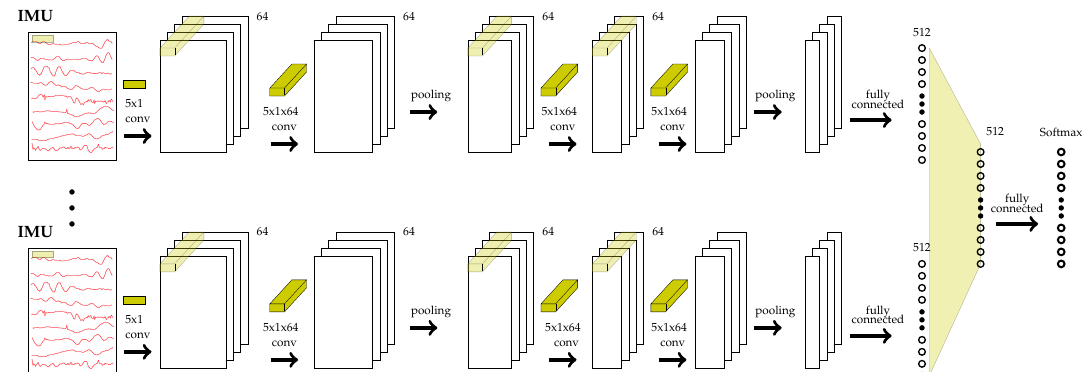
Figure 2. The CNN-IMU architecture contains m parallel branches, one per IMU. Branches are composed of B blocks, each with two [ 5 × 1 ] temporal convolutions and a [ 2 × 1 ] max-pooling. The outputs of the blocks are concatenated and forwarded to a fully connected layer. The output layer is the softmax